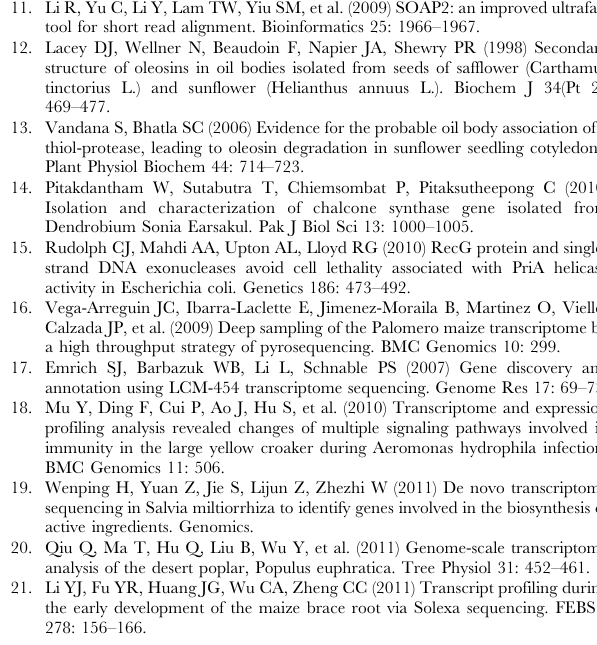
Table S1 Unigenes annotated as oleosin by GO. Table S2 Pathway annotation of unignenes from saf-